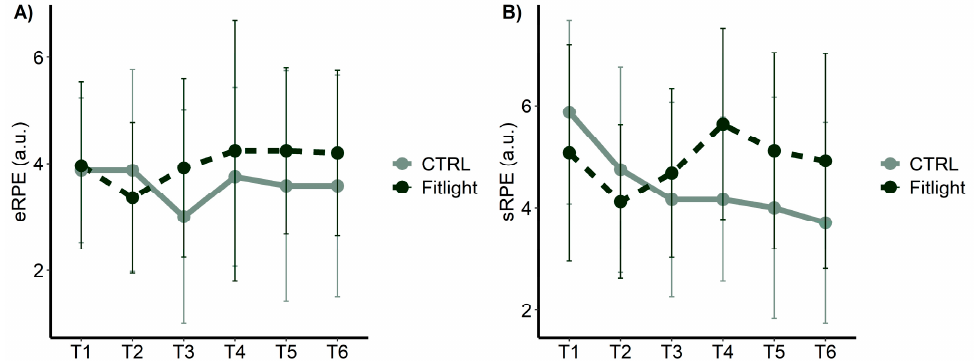
Figure 4. Rate of perceived exertion (RPE) measured over time and between groups in all conditions: ( a ) Exercise ratings of perceived exertion in arbitrary units; ( b ) session ratings of perceived exertion in arbitrary units.